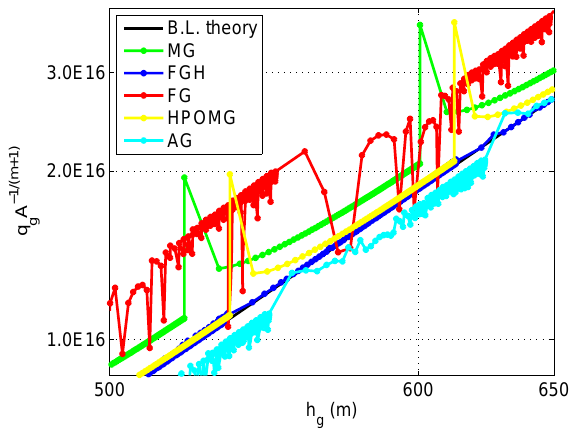
Fig. 4. Grounding line ice flux as a function of grounding line ice thickness over time according to EXP 1. Colour coding according to model type (see Fig. 3). Model output every 50yr (grid points). The solution according to the boundary layer theory (Schoof, 2007a) is given as a black line (hidden behind the SSA-H FGH